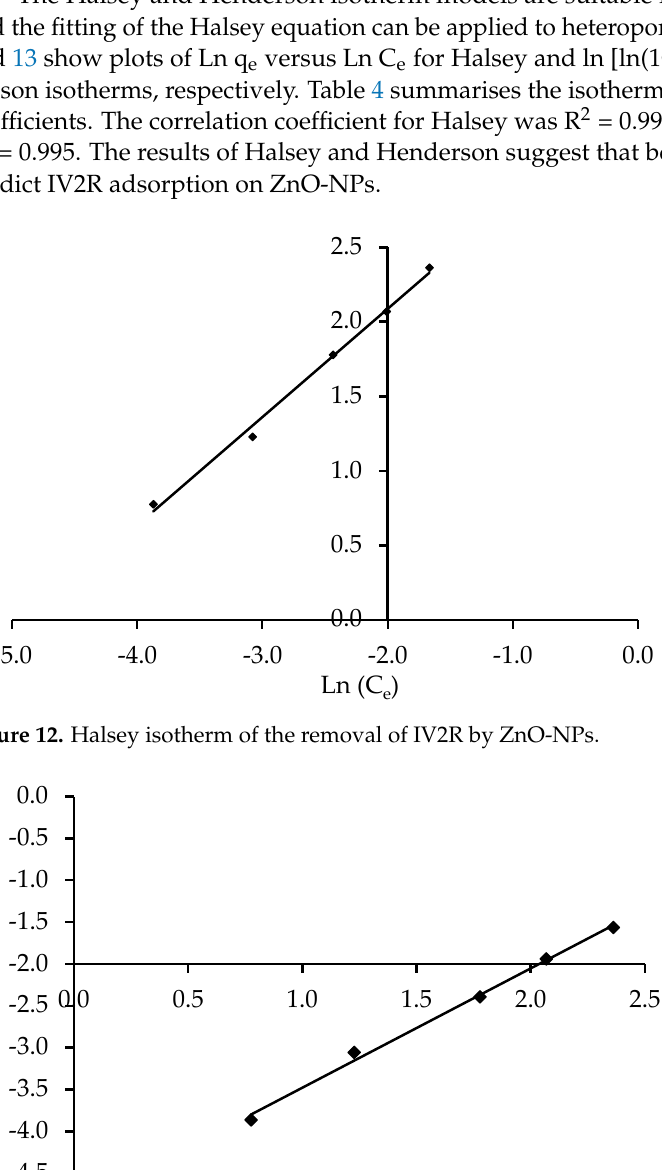
Figure 11. Harkins ‐ Jura isotherm of the removal of IV2R on ZnO ‐ NPs.